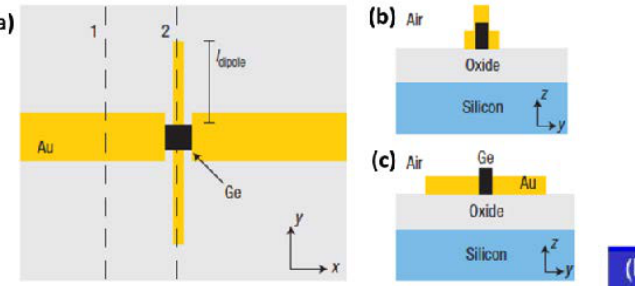
Figure 12: (a) Top view of the open-sleeve dipole antenna consist- ing of a dipole antenna oriented in the y direction and two line electrodes in the x direction. (b) Cross-section of the germanium nanowire lying under the two line electrodes. (c) Cross-section showing germanium in the gap region between the two antenna arms. Figures with reprint permission from: (a), (b) and (c) Ref. [23] ©2010 Nature Publishing Group.